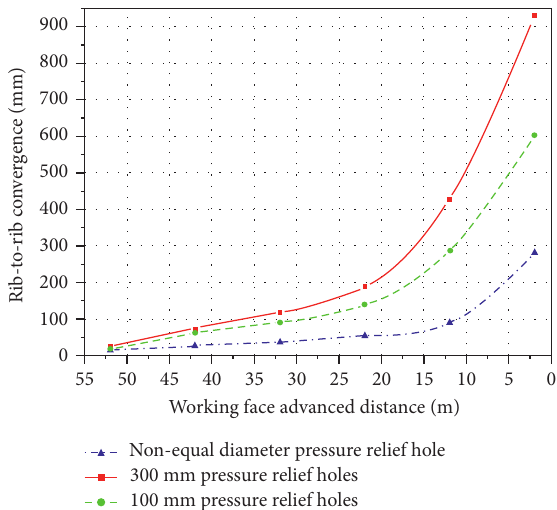
Figure 13: Rib-to-rib convergence